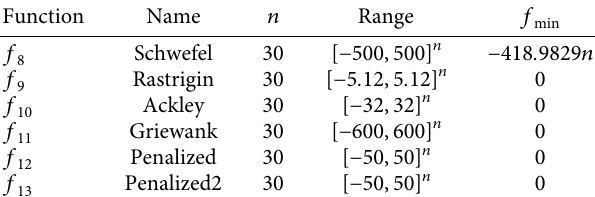
Table 2: Multimodal benchmark